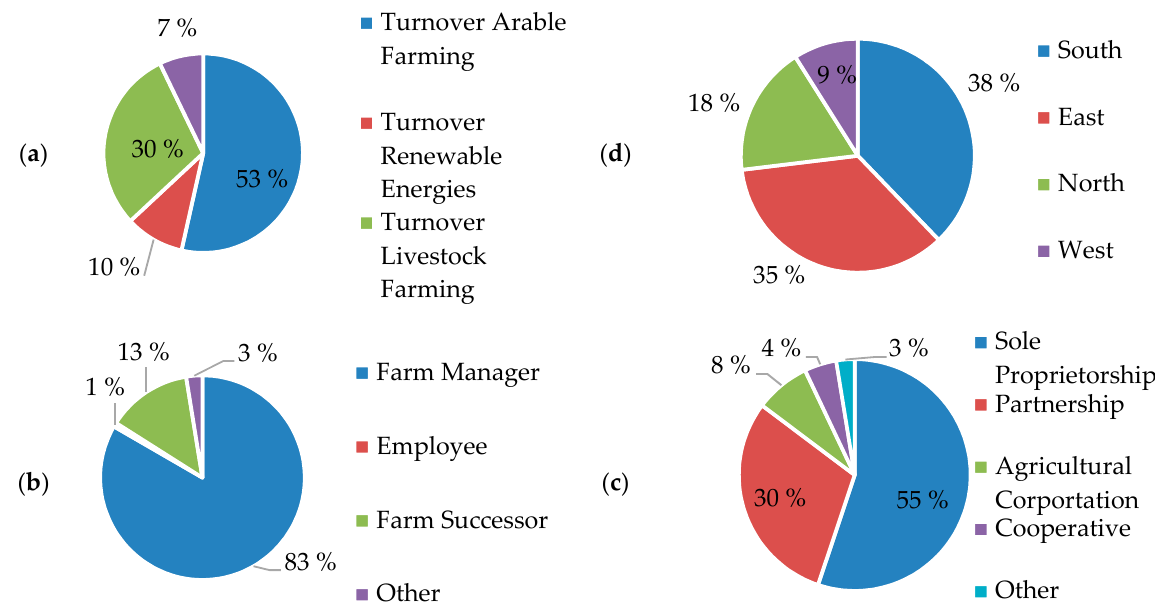
Figure 3. Descriptive statistics for the share of ( a ) each turnover in the total, ( b ) respondents’ position on the farm, ( c ) legal form of the agricultural holding as well as ( d ) regional distribution across Germany. East = farm location in Brandenburg, Saxony, Saxony-Anhalt, or Thuringia, North = farm location in Schleswig-Holstein, Lower Saxony, or Mecklenburg Western Pomerania; South = farm location in Baden-Württemberg or Bavaria; and West = farm location in North Rhine-Westphalia, Hesse, Rhineland Palatinate, or Saarland (German average: East = 0.07, North = 0.20, South = 0.47, and West = 0.25).